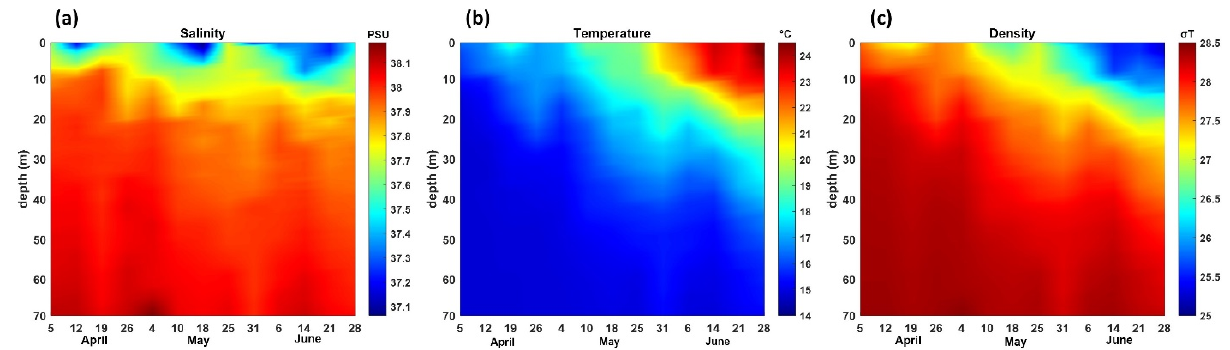
Figure 2. Hovmöller diagrams for S ( a ), T ( b ) and 𝜌 ( c ) for the studied period (March to June 2016) in the LTER-MC sampling site.